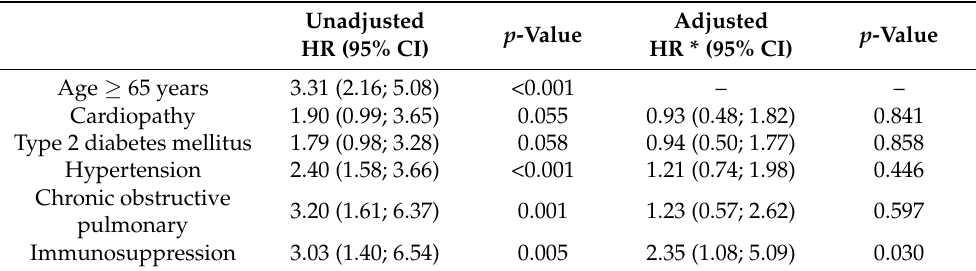
Table 2. Cox regression models for the incidence of SARS-CoV-2